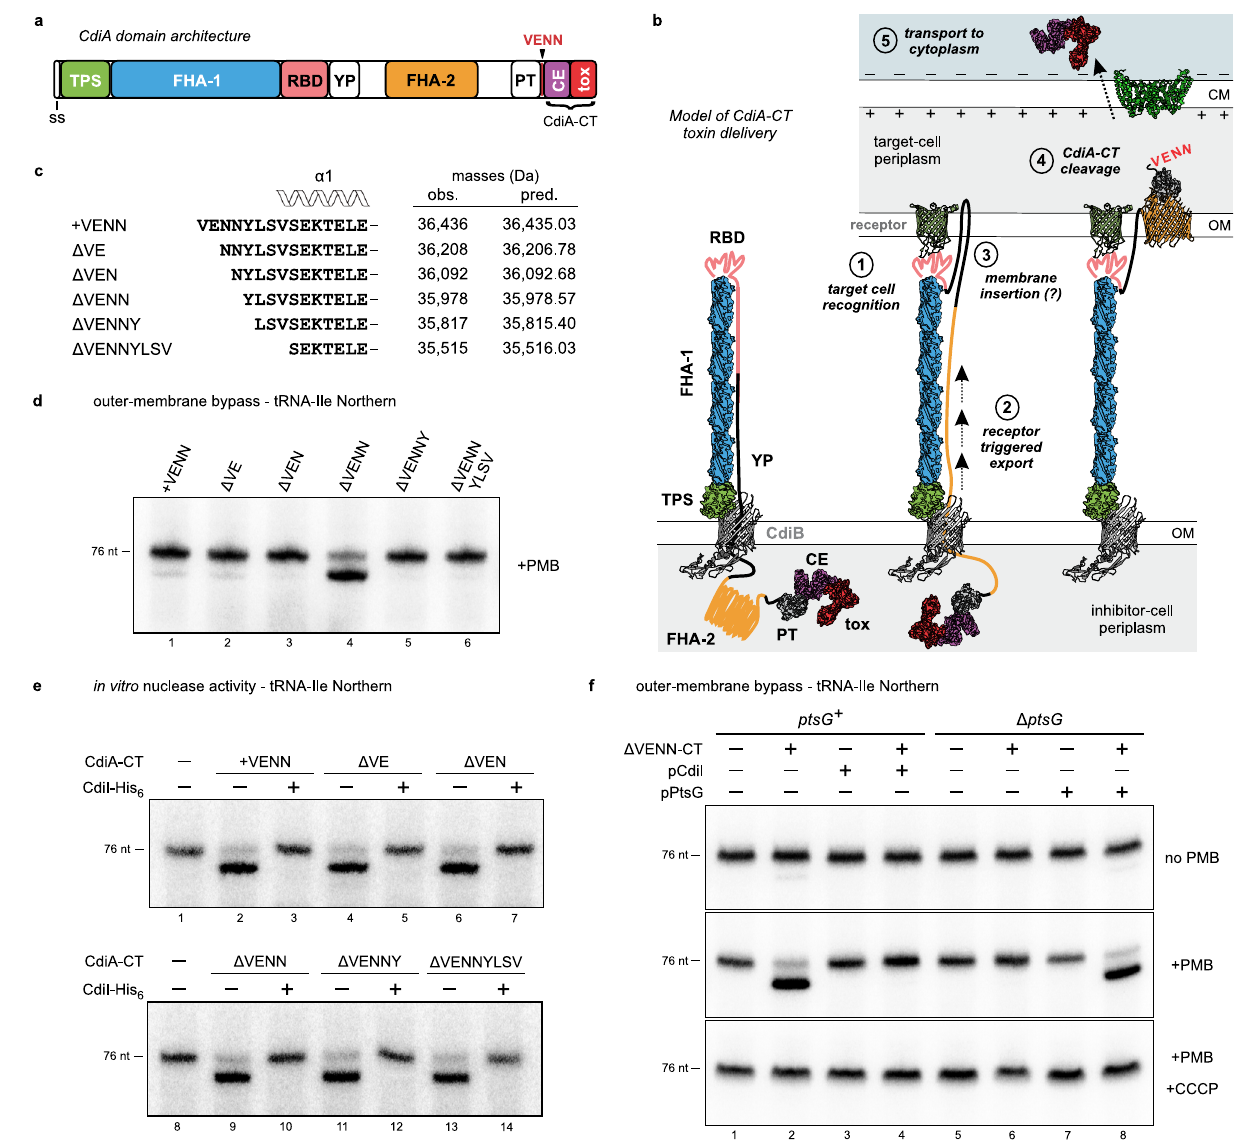
Fig. 1 | CdiA-CT processing is required for translocation into the target-cell cytoplasm. a E. coli CdiA protein domain arrangement. b Model of CdiA secretion arrest and receptor-triggered toxin delivery. c N-terminal sequences of CdiA- CT EC3006 variants used in outer-membrane bypass and in vitro tRNase assays. d Outer-membrane bypass assays. Puri fi ed CdiA-CT EC3006 variants were incubated with polymyxin B (PMB) treated E. coli cells. Total RNA was isolated for Northern blotanalysisusingaprobetotRNA Ile . e Invitronucleaseassays. E.coli totalRNAwas treated with puri fi ed CdiA-CT EC3006 in the absence and presence of CdiI EC3006 . Reactions were analyzed by Northern blotting using a probe to tRNA Ile . f